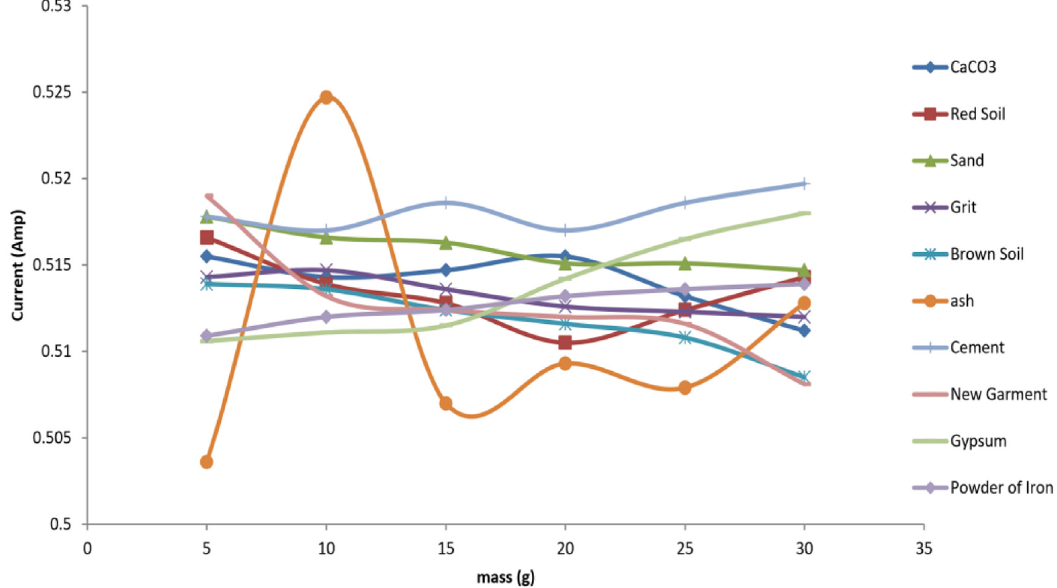
Fig. 2. Effect of changing the weight of the studied impurities accumulated on the current of PV cell.